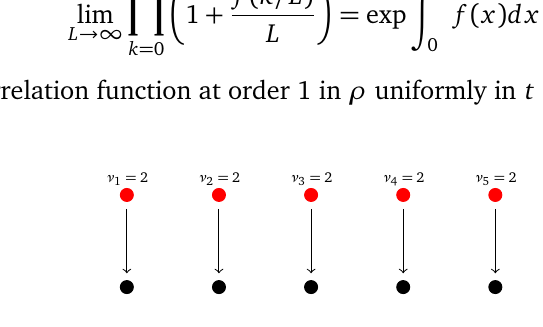
Figure 2: Sketch of configurations contributing to S